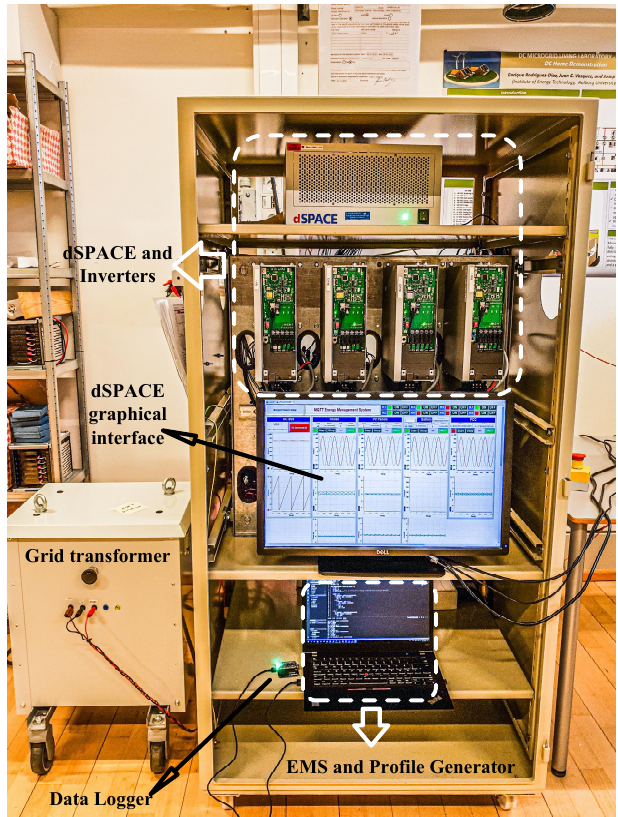
Figure 3. Experimental